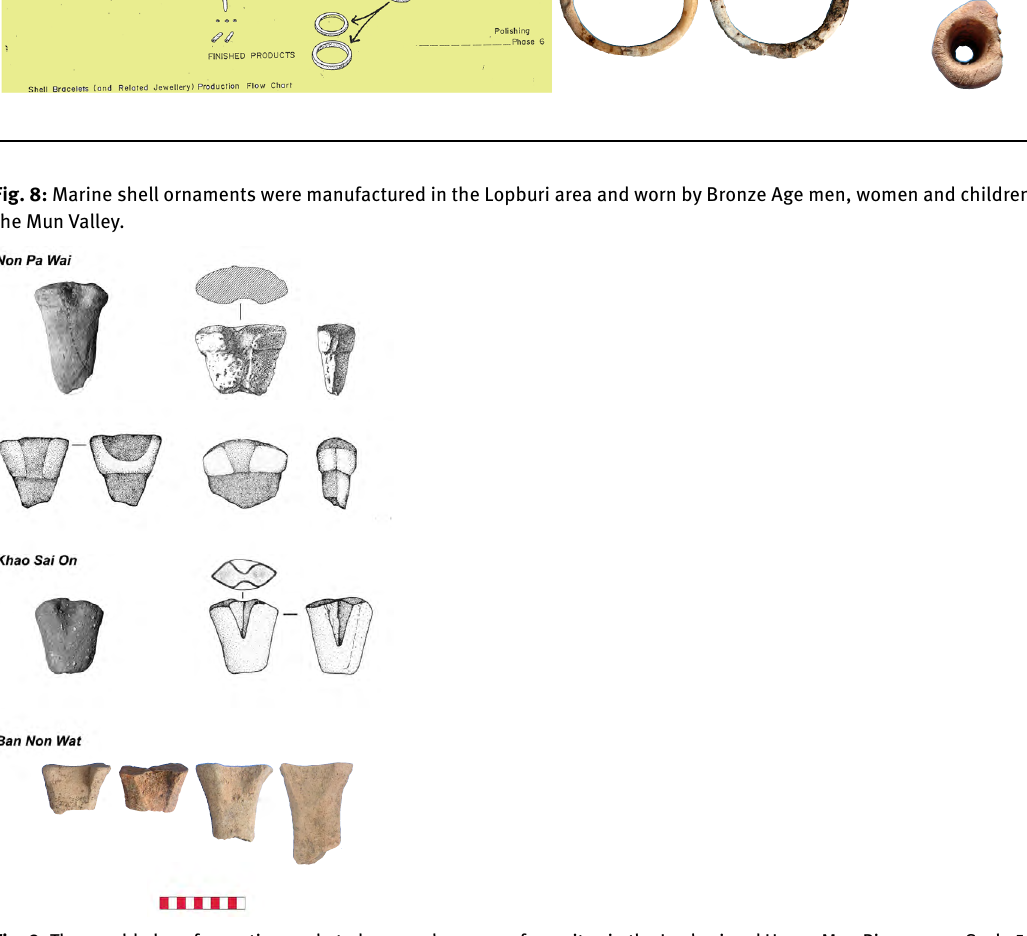
Fig. 9: The mould plugs for casting socketed copper-base axes from sites in the Lopburi and Upper Mun River areas. Scale 5